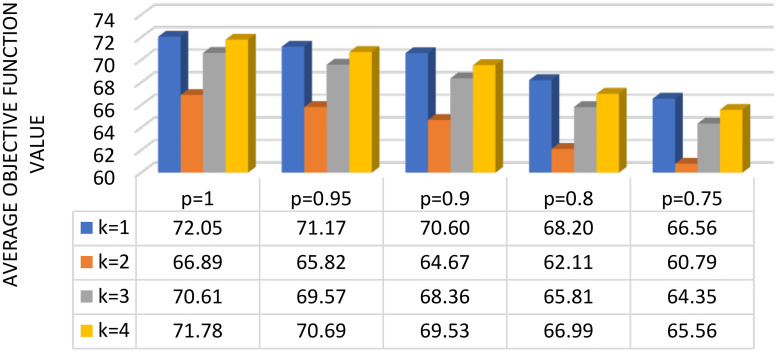
Summary of obtained average value of the objective function for different values of k and p.